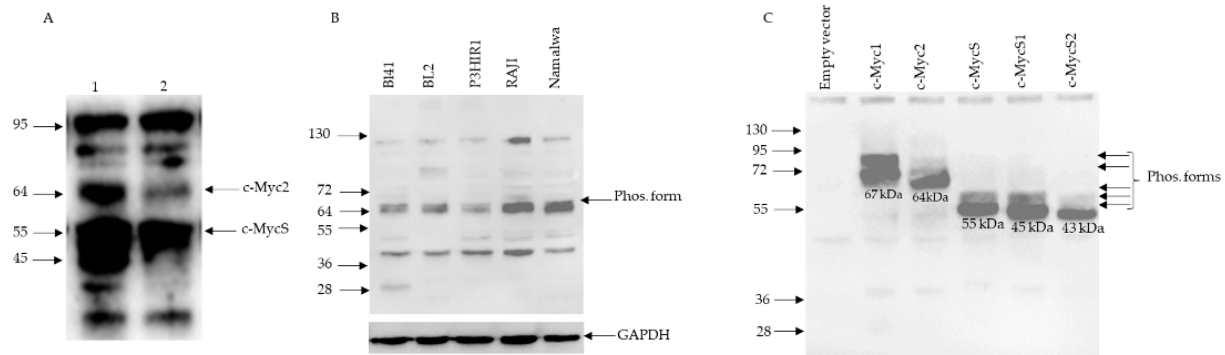
Figure 2. Analysis of the migration profile of c-Myc proteins by Western blot using the monoclonal antibody 9E10 directed against the conserved C-terminal part of c-Myc1, c-Myc2,c-MycS, and two other potential reading frames that were not previously described and named here c-MycS1 and c- MycS2 (Figure S1). ( A ) Typical results were obtained from cell extracts that were prepared from lymph nodes from two λ c-MYC ( A vy /a ) mice (lane 1, lane 2). ( B ) Results that were obtained from extracts that were prepared from BL cell lines. ( C ) Electrophoretic pattern of c- Myc1, c-Myc2, c- MycS, c-MycS1, and c-MycS2 proteins, obtained in vitro by transcription and translation of the open reading frames (Orf-c-Myc1, Orf-c- Myc2, Orf-c-MycS, Orf-c-MycS1, and Orf-c-MycS2) cloned sep- arately into the pT7CFE1 vector (Figure S2). The apparent molecular weight of the different bands is shown on the left; Empty vector: Negative control; Phos. Form: Phosphorylated form; GAPDH: loading control.